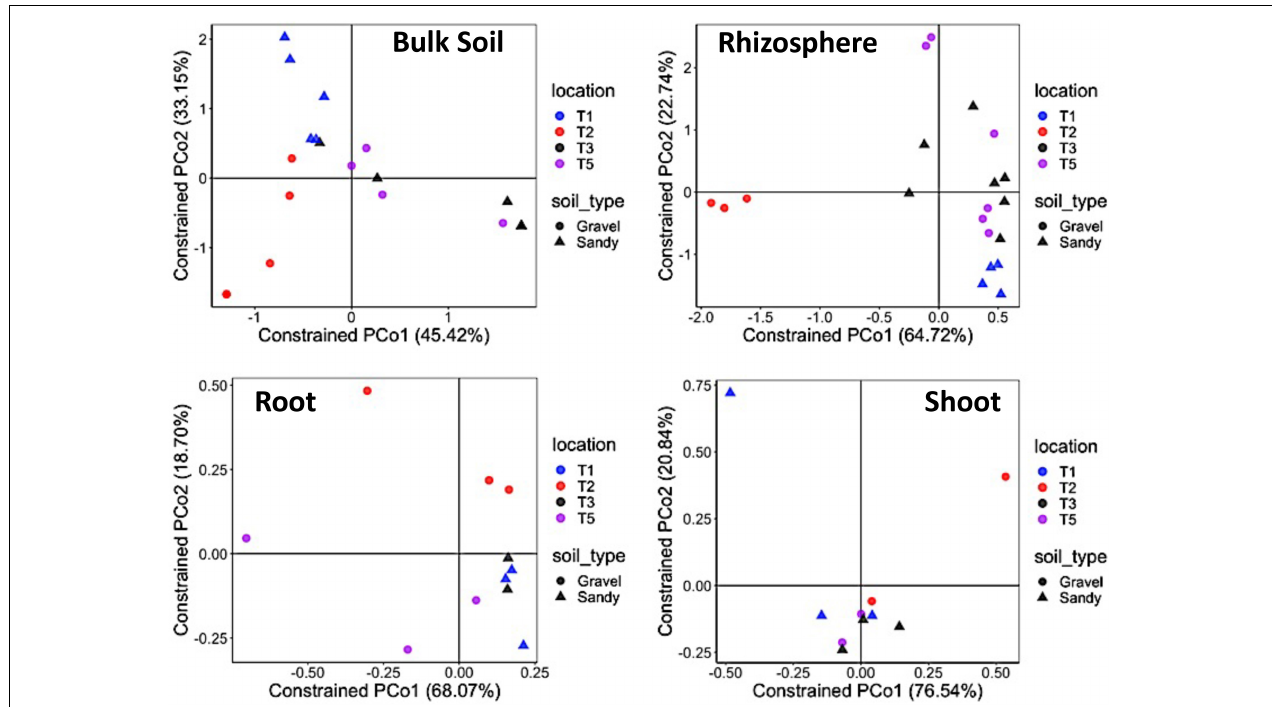
FIGURE 5 | Fungal community structure in each specific sampling compartment. Constrained analysis of principal coordinates (CAP) based on the Bray-Curtis distance matrix of the ITS ASV table shows samples’ ordination according to the sampling location and soil type in each compartment separately. The percentage of variation explained by the two first axes is provided for each graph. Different colors stand for the four locations, while different symbols stand for the two soil